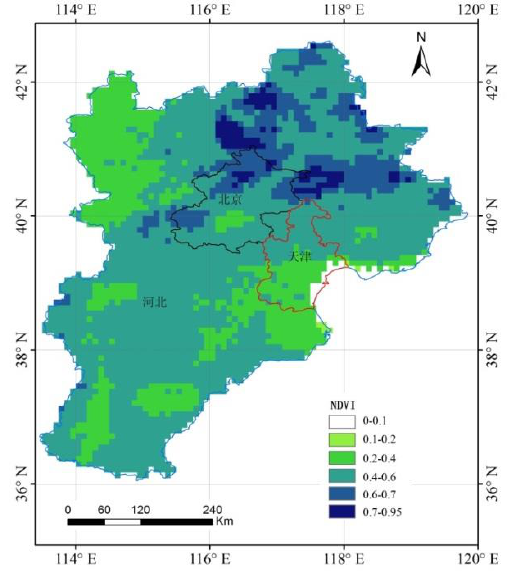
Figure 1 Spatial distribution of GIMMS NDVI3g in the Beijing-Tianjin-Hebei region between 1982 and